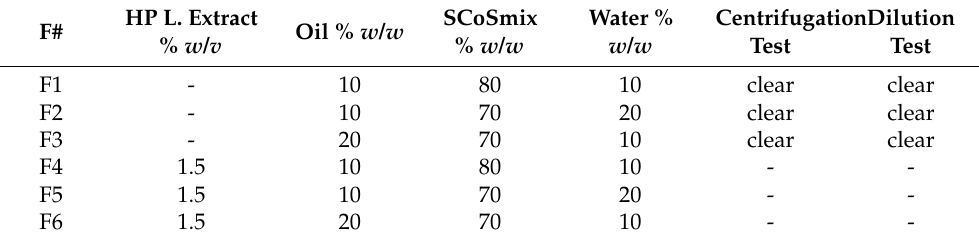
Table 1. NE composition and physical